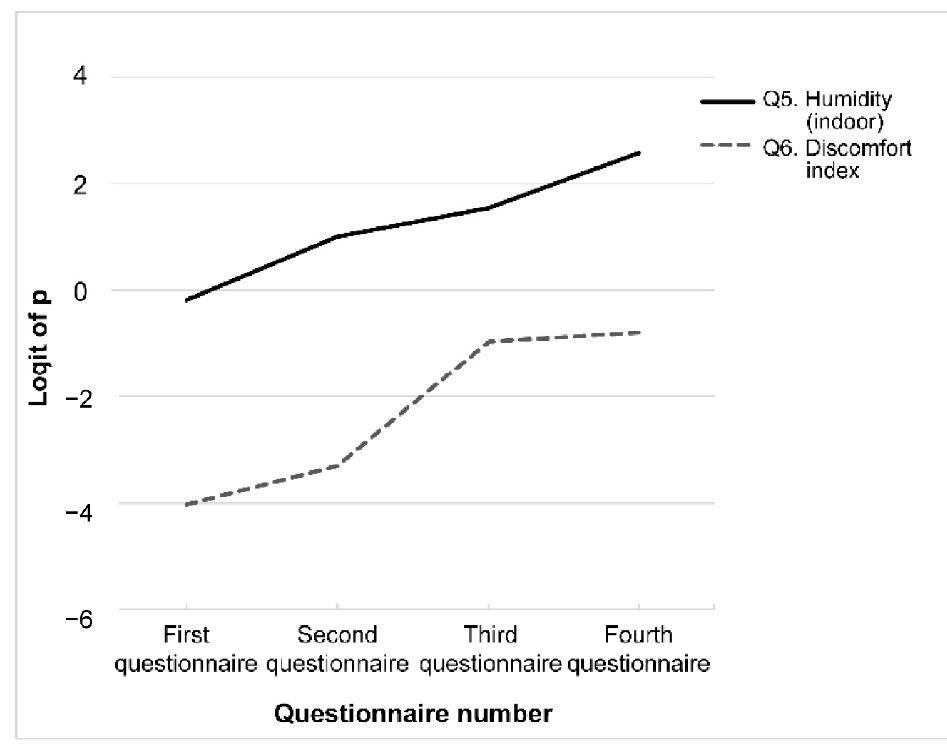
Figure 5. Pattern #3: Minimal variation over time. Questions with an estimated correct answer rate of minimal variation were selected. Each question is indicated using a different line.